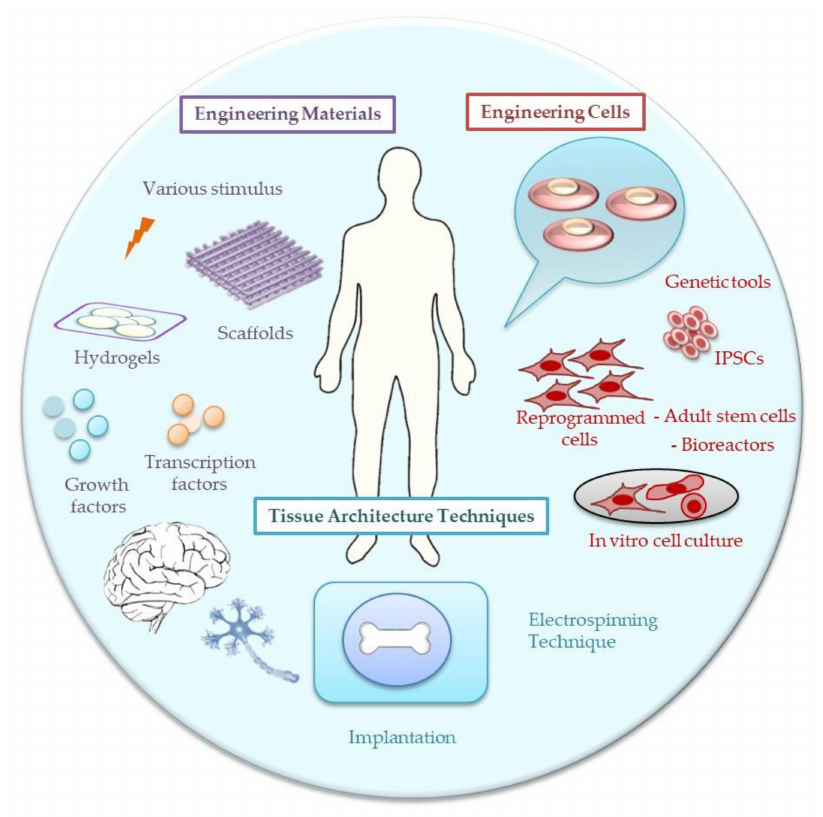
Figure 1. Engineering material, cell and tissue architecture techniques dedicated to the tissue engineering